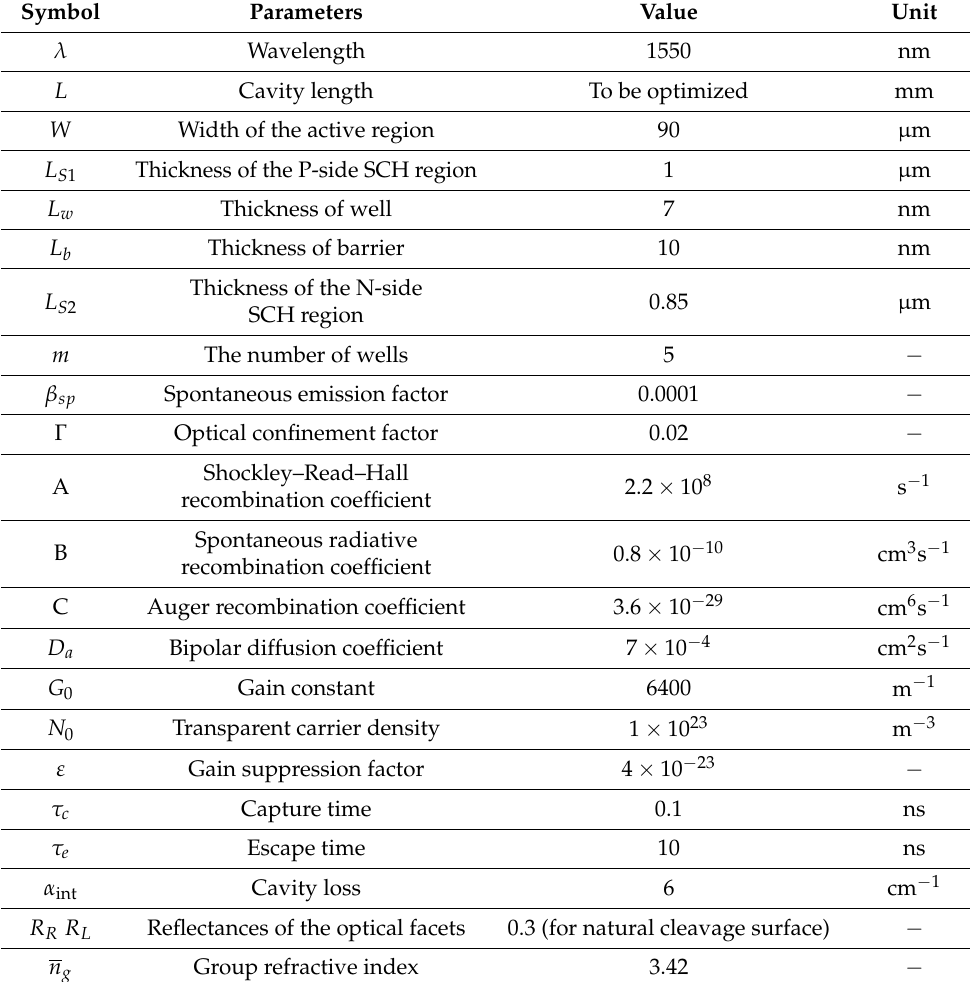
Table 1. Values of the model